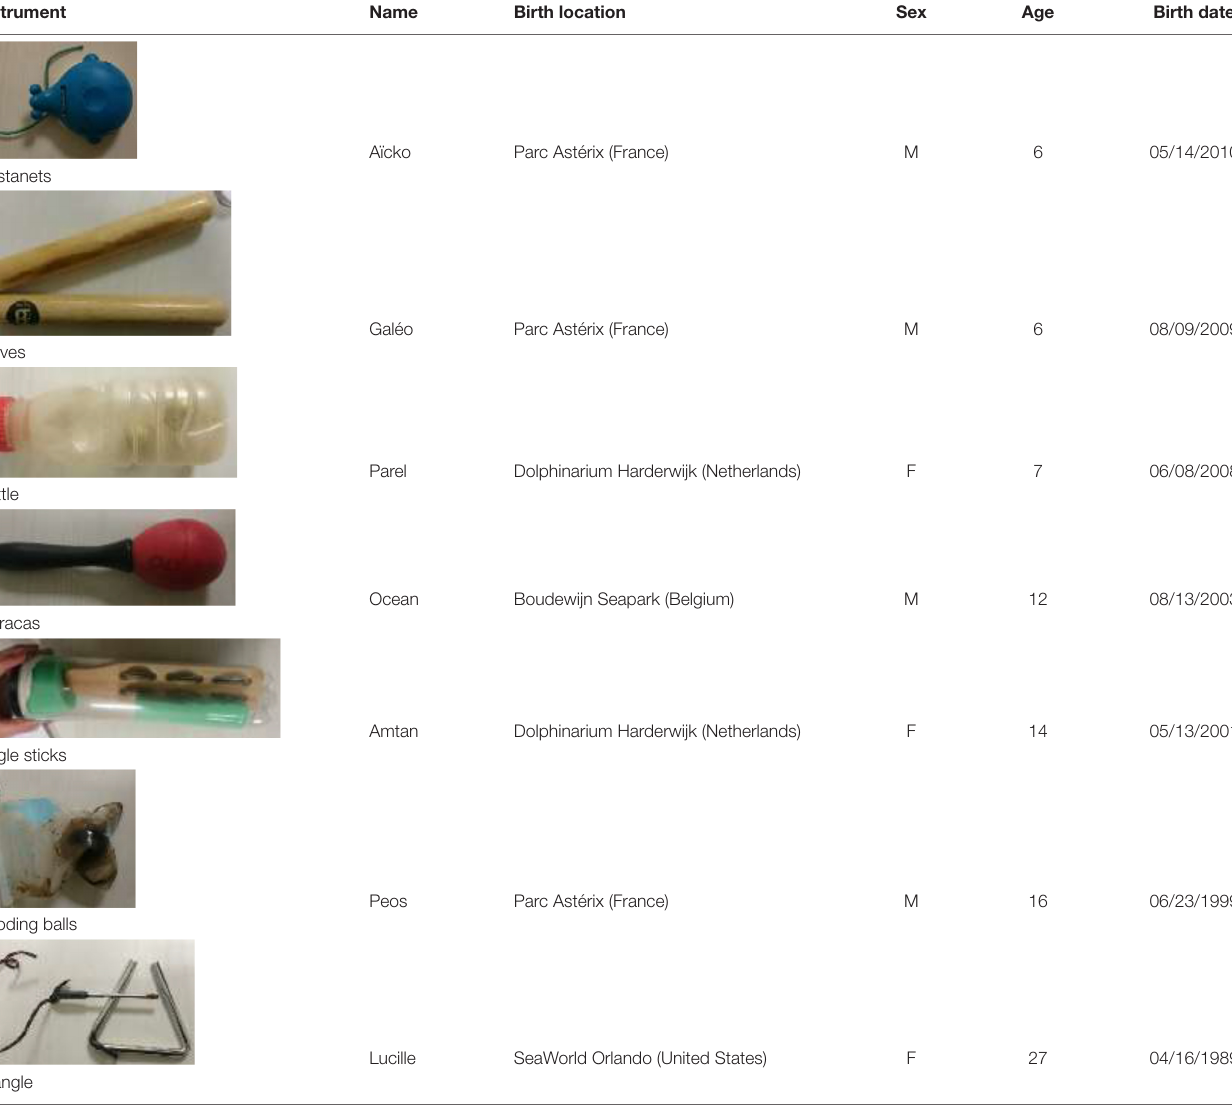
TABLE 1 | Instruments assigned to each individual and characteristics of the animals (M: male, F: female). Instrument